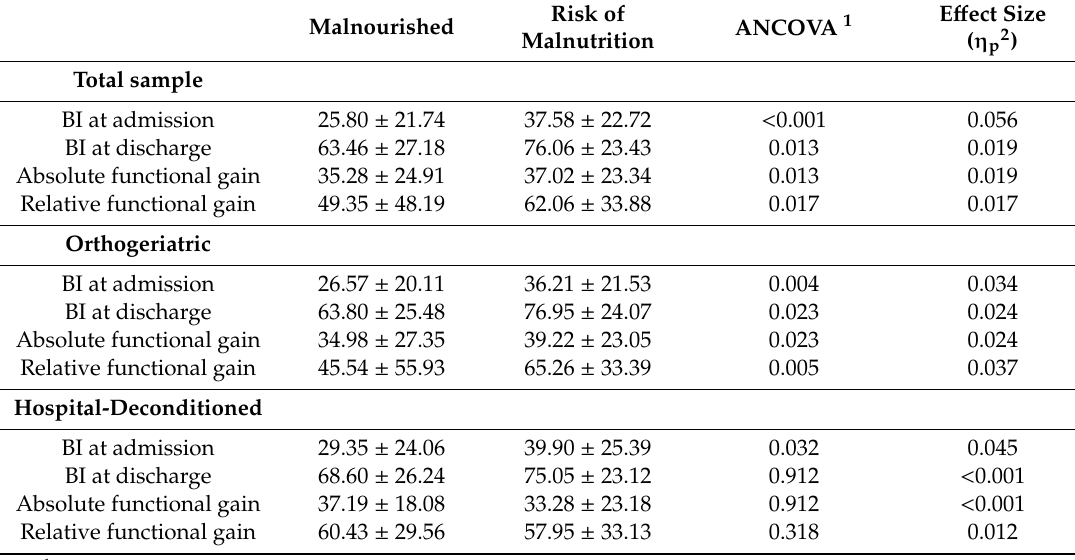
Table 3. Functional outcomes according to nutritional